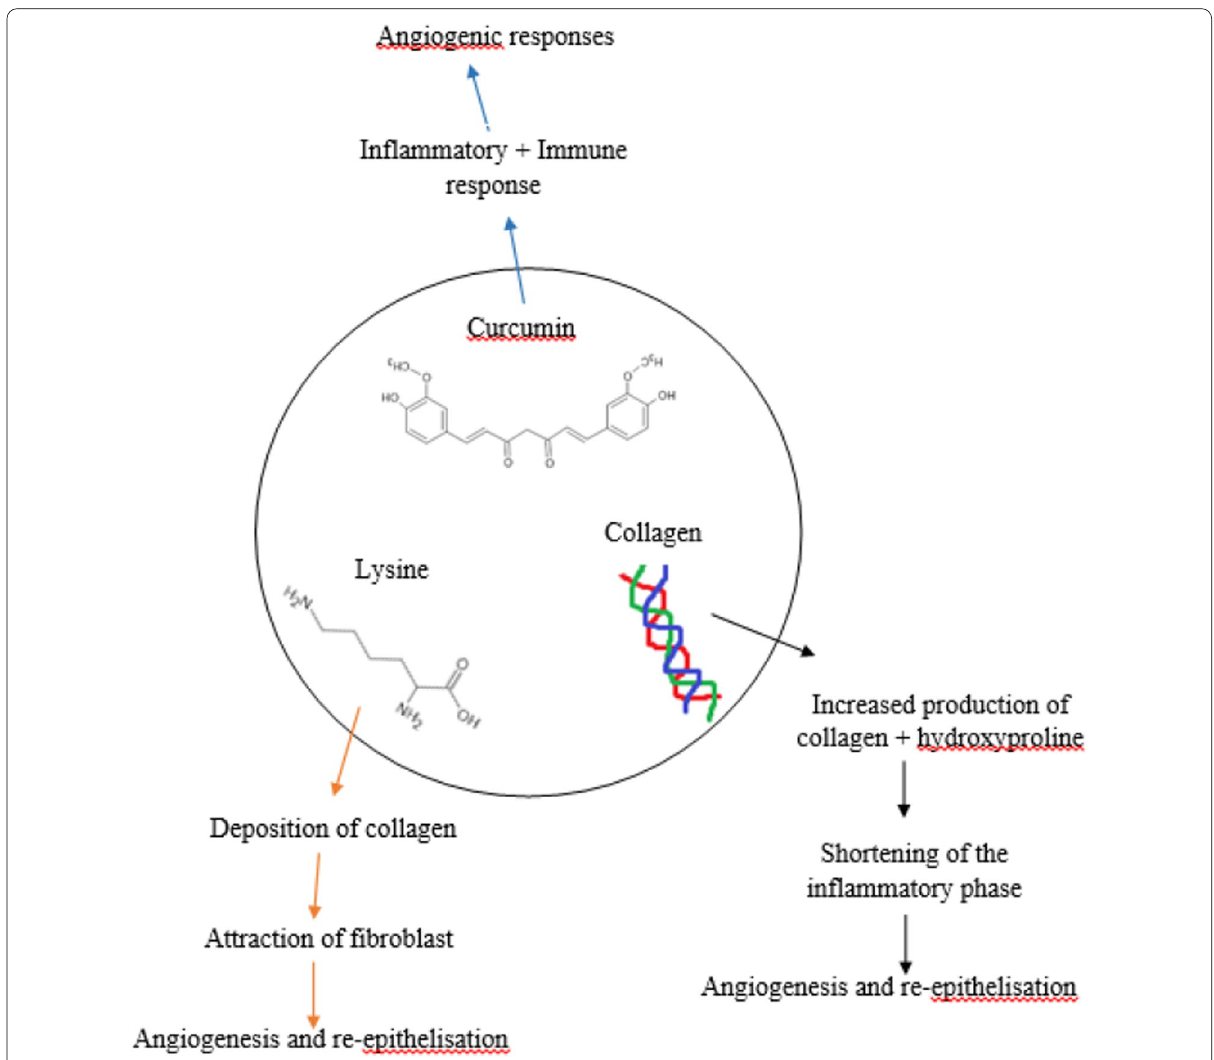
Fig. 1 Structural mechanisms of wound healing resulting from curcumin, collagen, and lysine